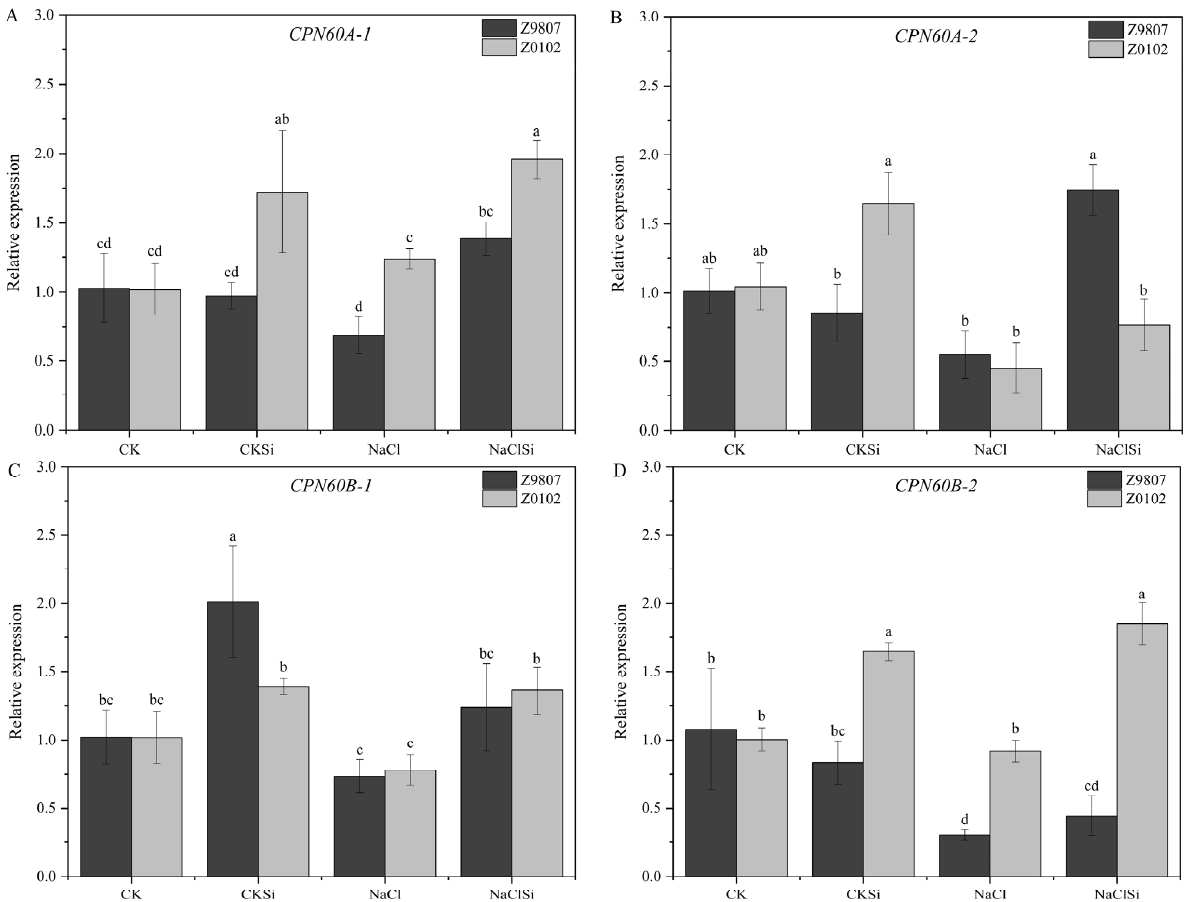
Figure 12. Effects of Si on transcript levels of RubisCO genes. ( A ) relative expression of CPN60A-1 ; ( B ) relative expression of CPN60A-2 ; ( C ) relative expression of CPN60B-1 ; ( D ) relative expression of CPN60B-2. Vertical bars represent ± S.E. ( n = 3). Same letter means not different among treat- ments at p ≤ 0.05. Different letters mean significantly different among treatments at p ≤ 0.05.